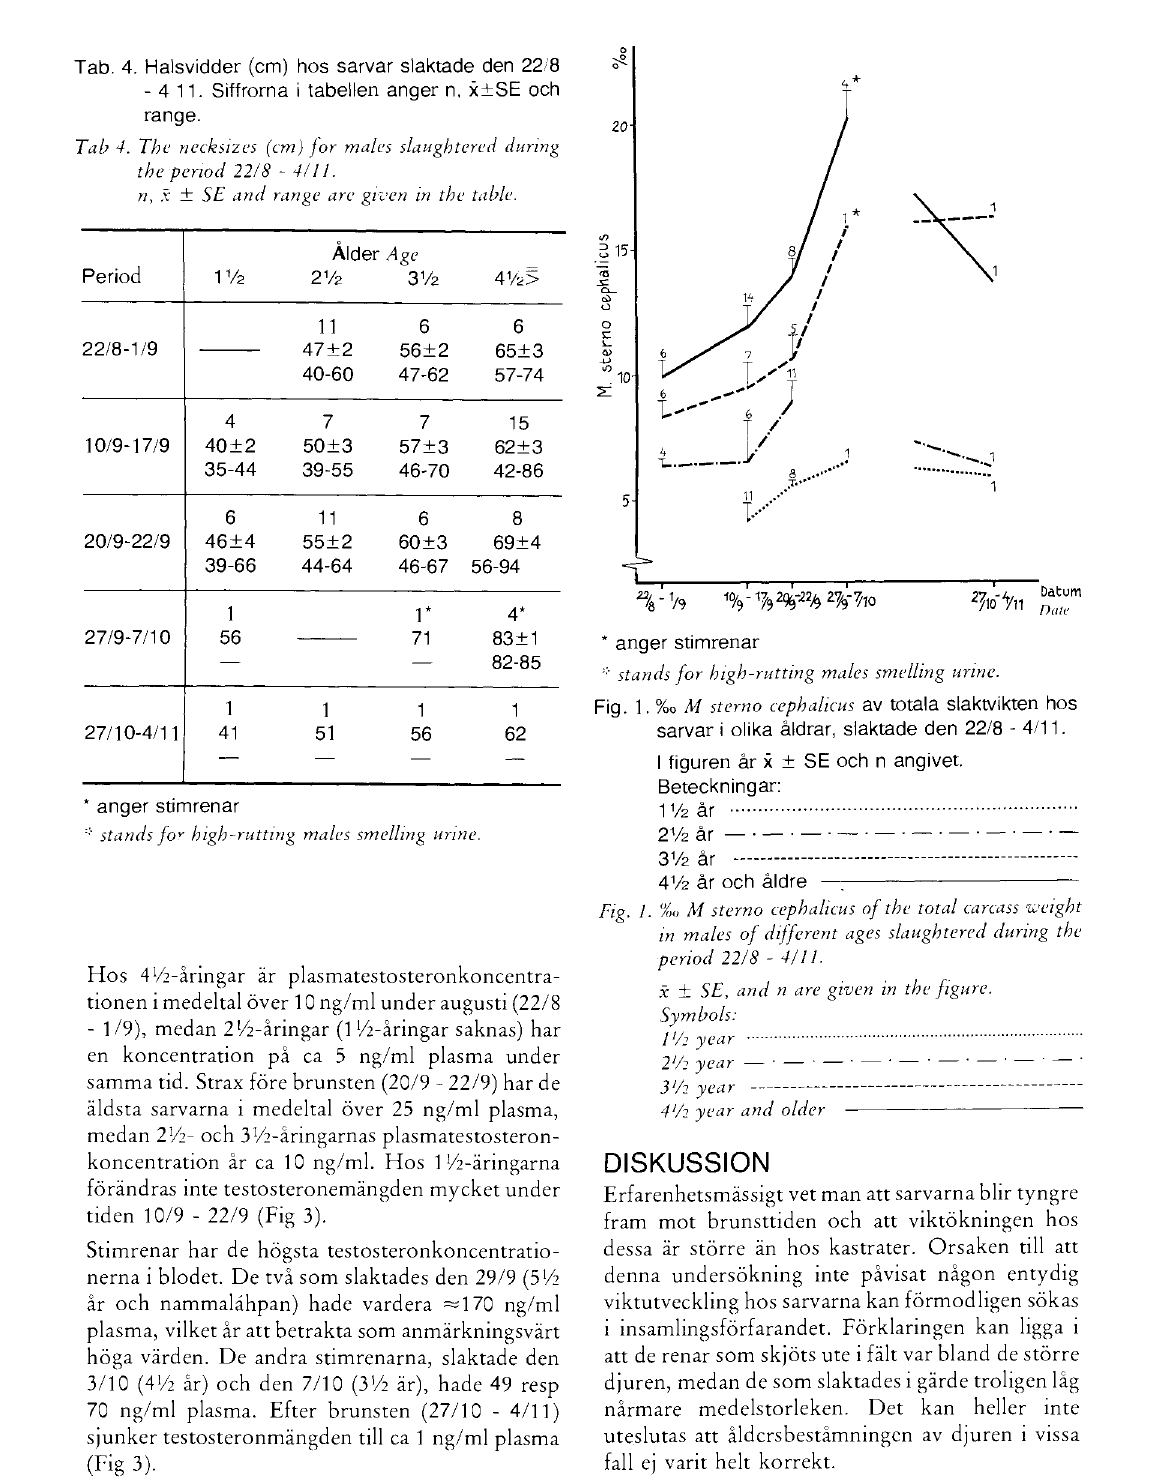
Tab. 4. Halsvidder (cm) hos sarvar slaktade den 22 8 -411. Siffrorna i tabellen anger n, x±SE och range. Tab 4. The necksizes (cm) for males slaughtered during the period 22/8 -4/11. n, x + SE and range arc given in the table.